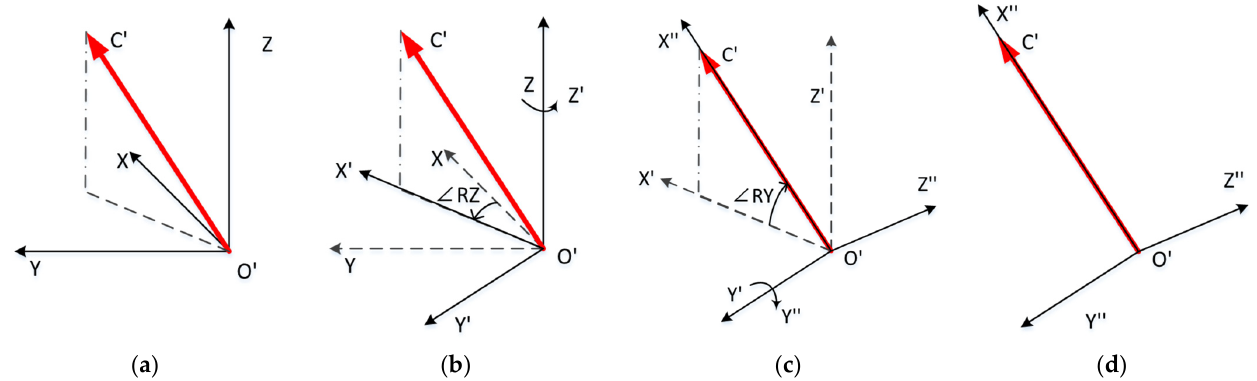
Figure 11. Euler angle diagram: ( a ) end effector origin coordinate system; ( b ) coordinate system after rotating RZ around z axis; ( c ) coordinate system after rotating RY around y axis; ( d ) the x axis of the end effector coincides with the calculated